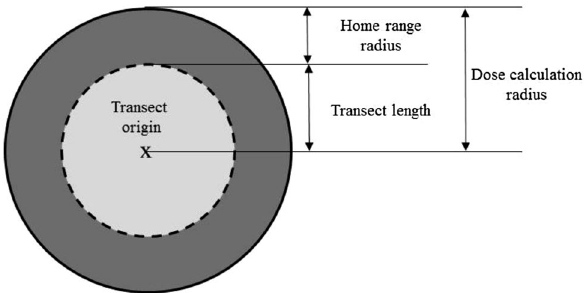
Figure 9. Definition by species of its potential exposure area from which the dose (rate) is